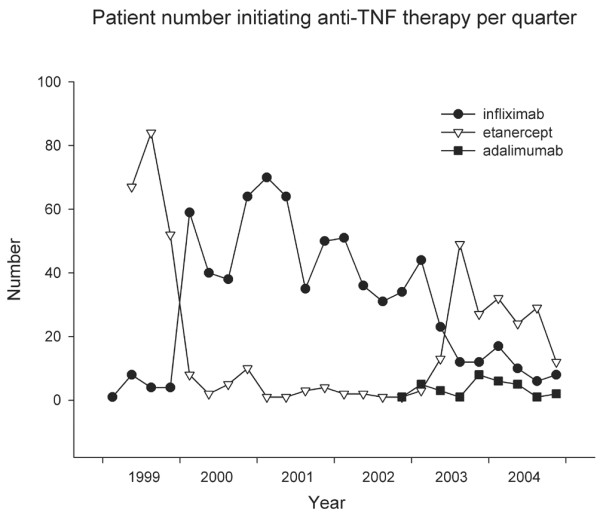
Number of patients starting anti-tumour necrosis factor (TNF) therapy during the observational period. The figure presents the number of rheumatoid arthritis patients, per quarter, starting infliximab, etanercept, or adalimumab for the first time during the period of 1999 through 2004 in southern Sweden.